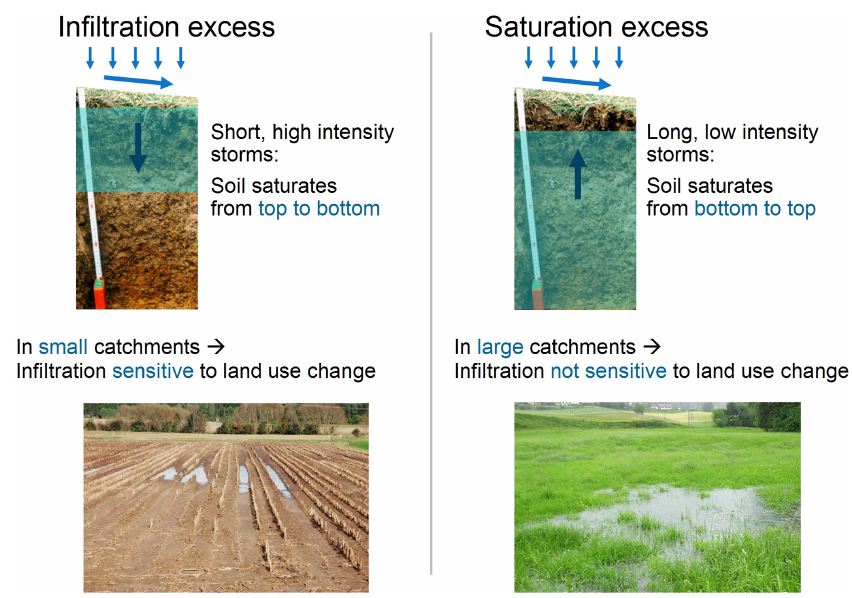
Figure 5. Two runoff generation mechanisms and their impact on the sensitivity of flood runoff to land-use change. Left: The infiltration excess runoff generation mechanism often occurs in small catchments because the most critical storms tend to be short and of high intensity. In this mechanism, the soil saturates from the top to the bottom, and surface runoff is generated if the rainfall intensity exceeds the infiltration capacity. Right: The saturation excess runoff generation mechanism often occurs in large catchments because the most critical storms tend to be long and of lower intensity. In this mechanism, the soil saturates from the bottom to the top, and surface runoff is generated once the entire soil column is filled. Photos: Erwin Murer, Erwin Zehe.